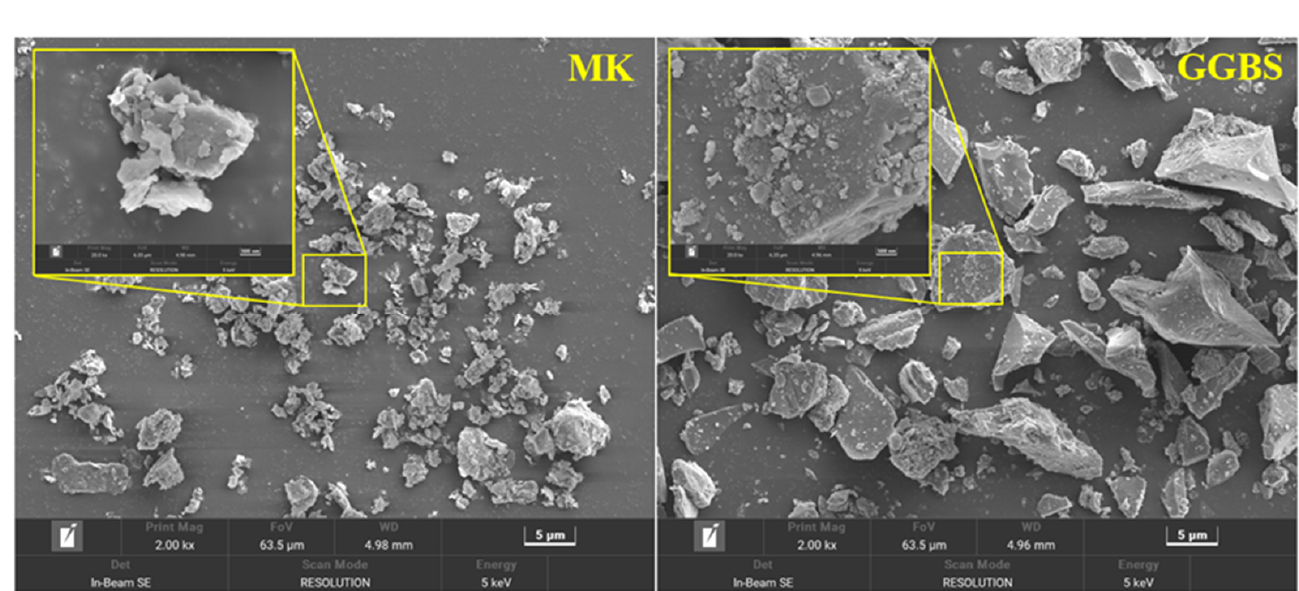
Figure 1. Morphology of the precursors.